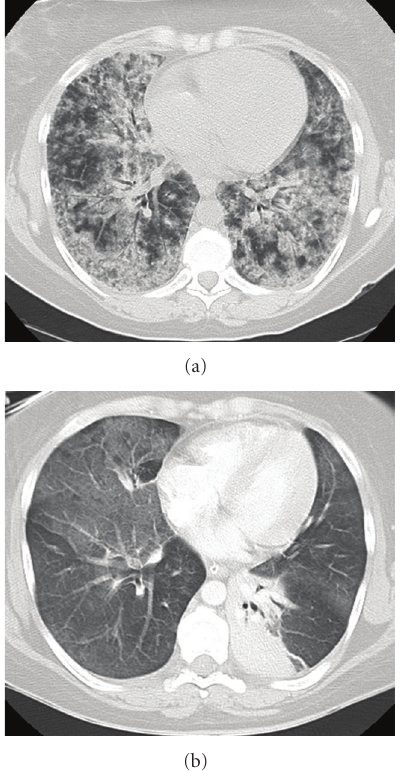
Figure 2: (a) CT scan of the chest obtained on day 1 showing di ff use alveolar infiltrate. (b) CT scan of the chest obtained on day 8: right ground glas opacities and atelectasis of the left lower